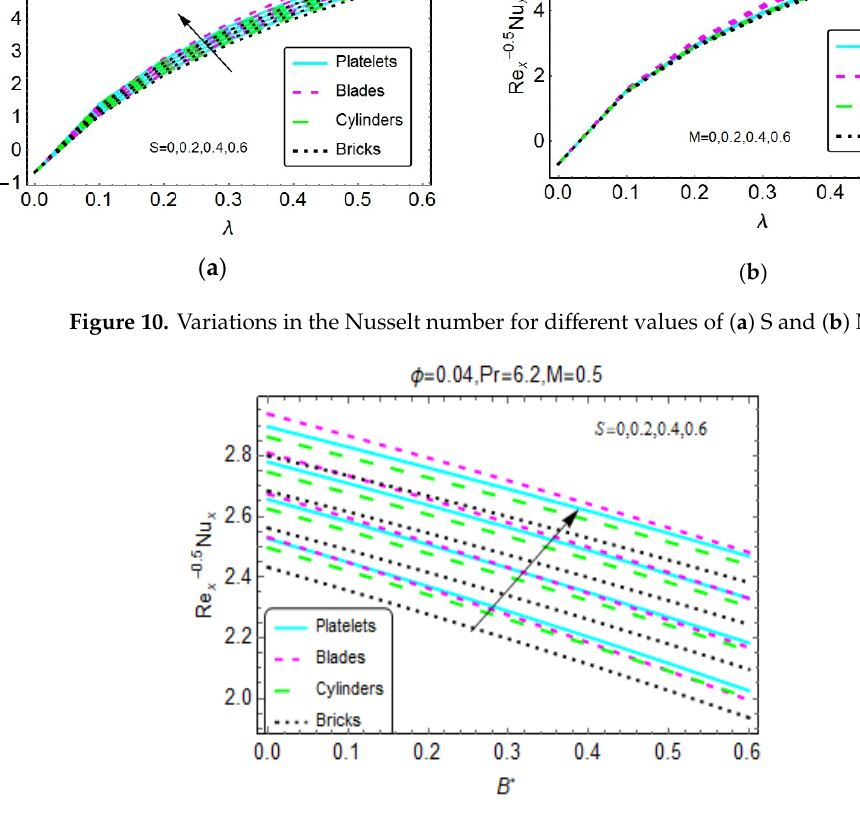
Table 6. Comparison with scientific literature for ϕ (cid:3404) 0, M (cid:3404) 0, a ∗ (cid:3404) 0, b (cid:3404) 0 .